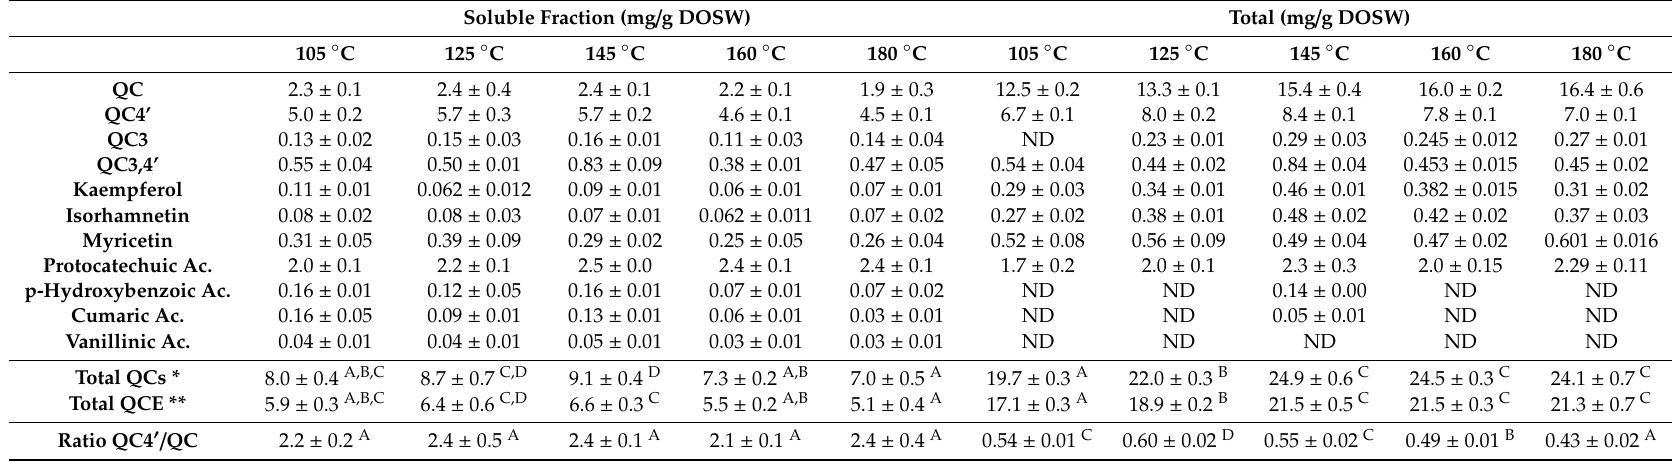
Table 3. Composition of the extracts obtained at di ff erent temperatures using subcritical water. It is presented the soluble fraction and the total content in phenolic compounds (re-dissolved in ethanol) of the extracts.